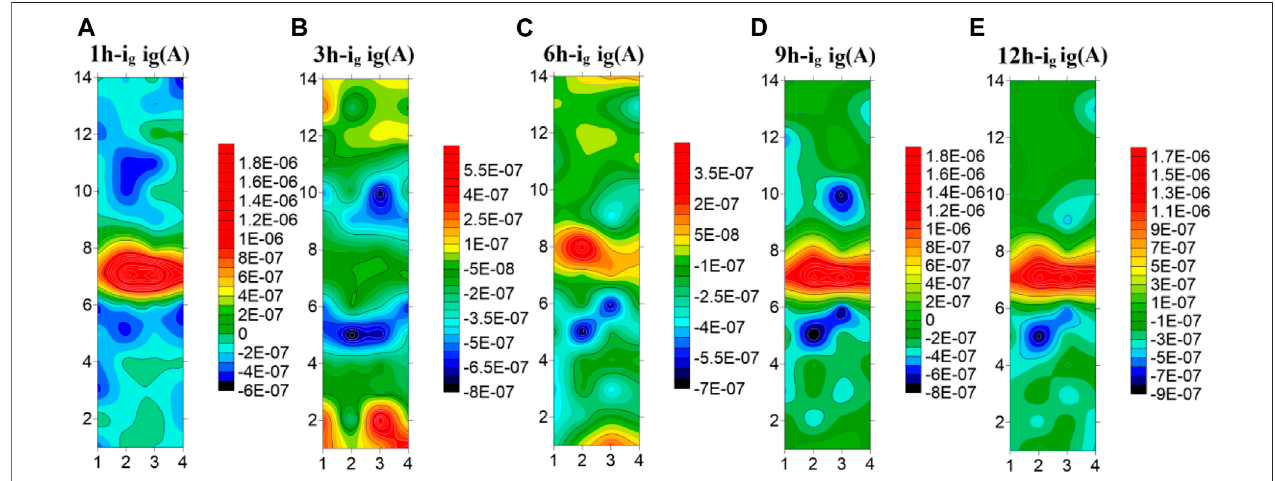
FIGURE 9 | Microelectrode array test results of titanium alloy welded joint soaked in seawater for 12 h at 45 ° C (A) 1 h (B) 3 h (C) 6 h (D) 9 h (E) 12 h.